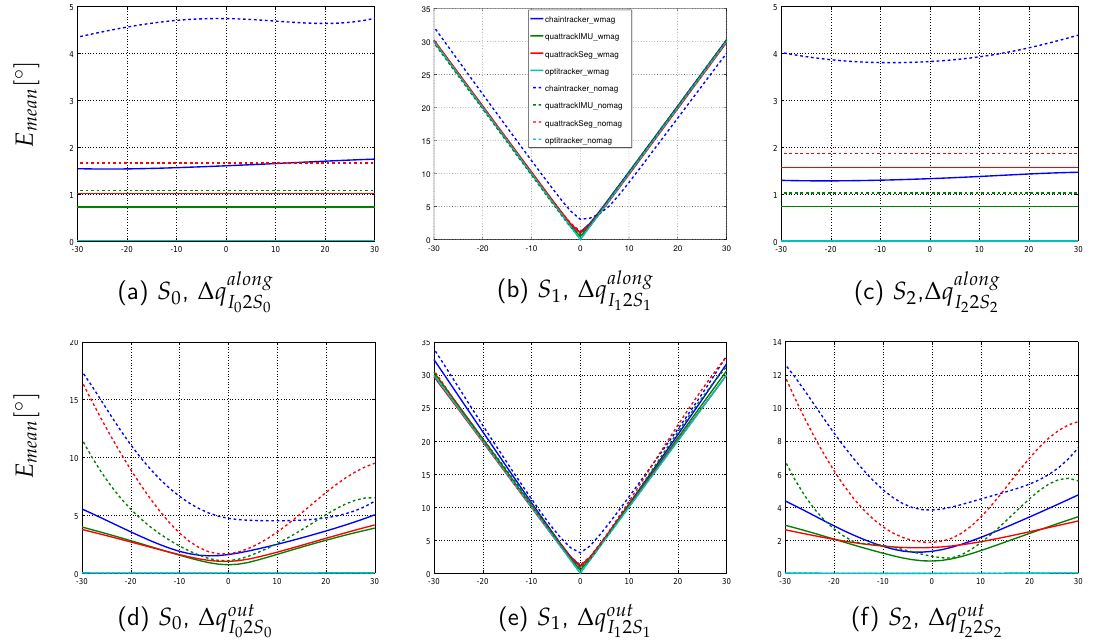
Figure 5. Simulation scenario: Per segment mean angular error distributions on sim-fast for along-bone and out-of-bone I2S orientation calibration errors (cf. Section 2.6.3).